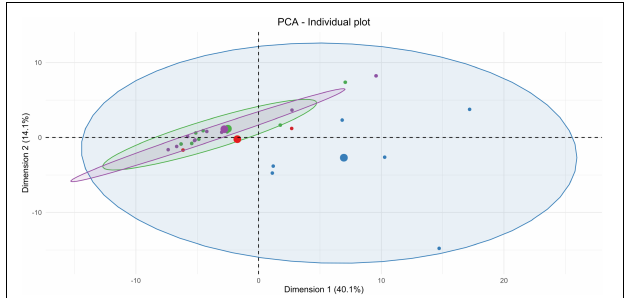
FIGURE 6 | Unsupervised multivariate analyses on urine metabolome between control and insonified groups. Score plot of principal component analysis (PCA) constructed with metabolites within the urine metabolome after acoustically-mediated BBB opening (BBBO). Larger dots are inertial centers of ellipses (center of a sample group) plotted based on smaller dots representing each sample individually. Red dots are control samples; Blue dots are 3-h post-BBBO samples; Green dots are 2-days post-BBBO samples; Purple dots are 1-week post-BBBO samples. Two samples having the same metabolic profile will be clustered in the same dimensional space.